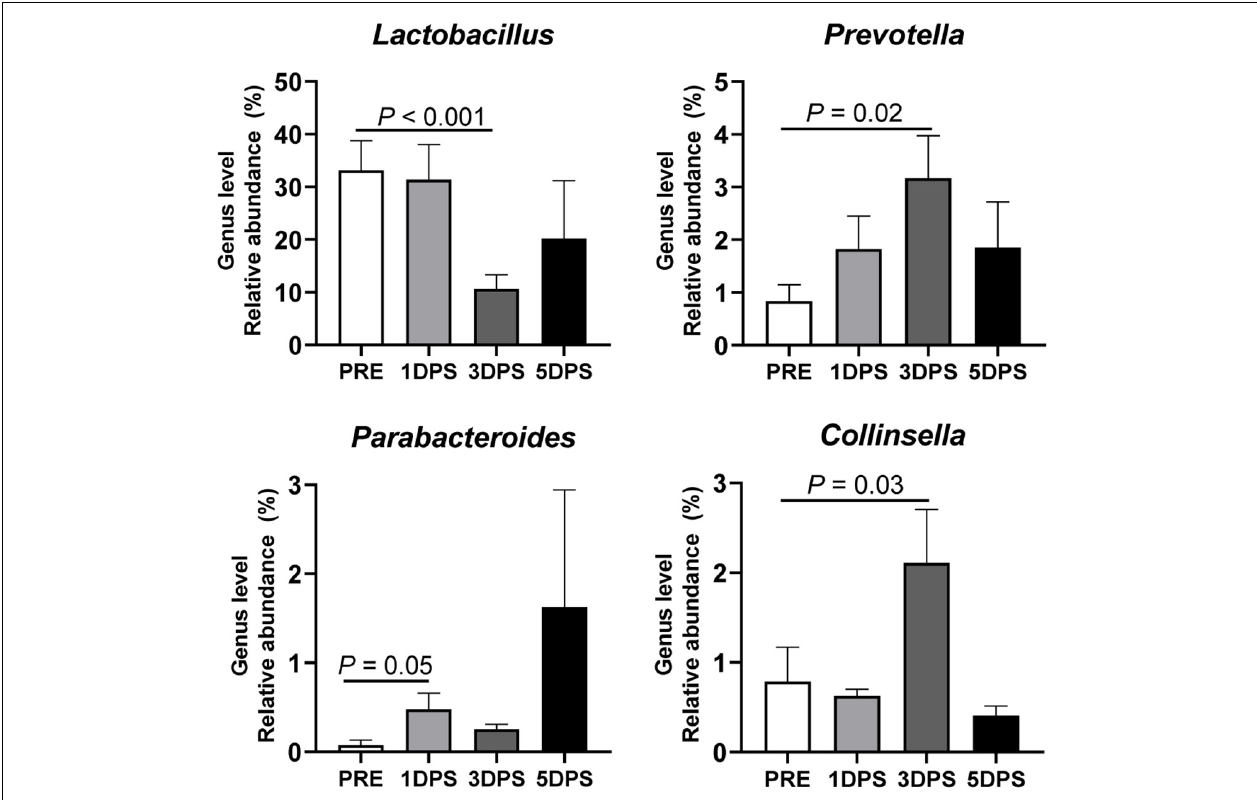
FIGURE 7 | Stroke resulted in genus-level perturbations in gut microbiota between pre- and poststroke in middle cerebral artery occlusion (MCAO) pig model. The abundance of Lactobacillus , Prevotella , Parabacteroides , and Collinsella showed > 1% relative abundance and demonstrated a significant change in abundance during acute stroke. P- value: Paired t- test comparing the mean prestroke values vs. each time point poststroke. Prestroke (PRE, n = 7), 1 day poststroke (1DPS, n = 7), 3 DPS ( n = 6), and 5DPS ( n =